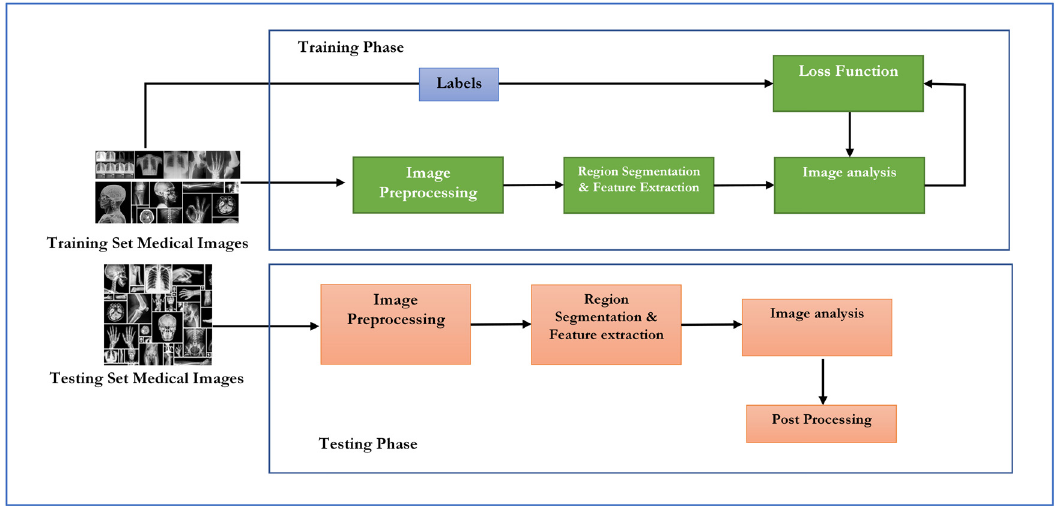
Figure 2: Radiography image analysis